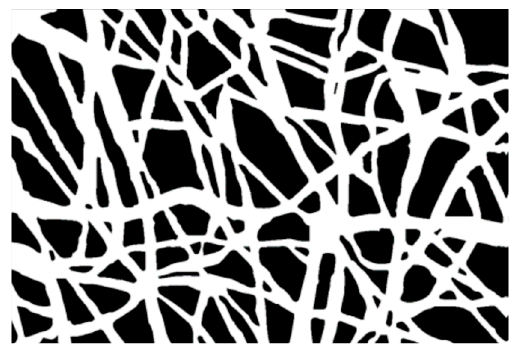
Figure 2. The image after 'image trace' operation (in Adobe Illustrator).